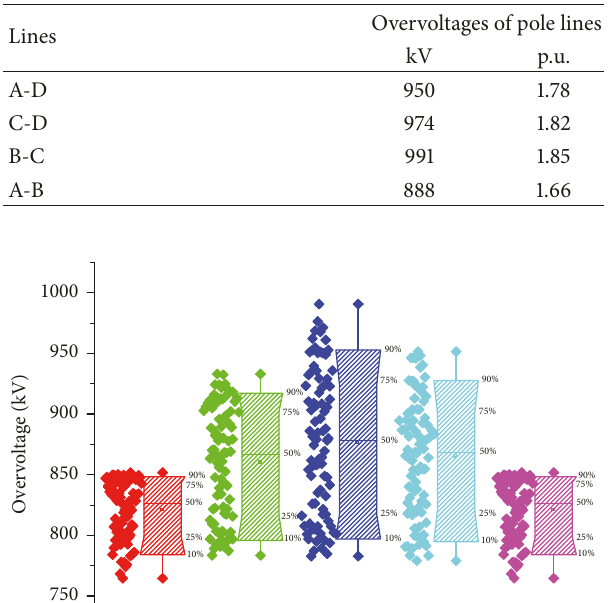
Table 1: Overvoltages of transmission lines under normal mode.